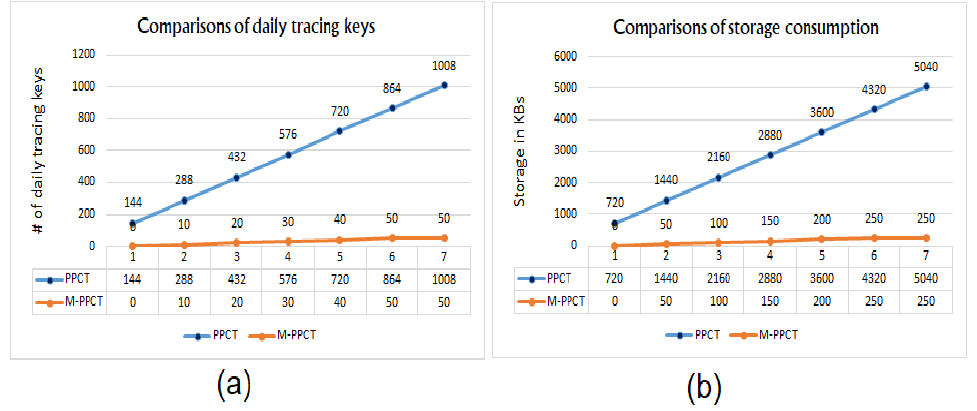
Figure 15. PPCT versus M-PPCT: comparisons of number of keys ( a ) and storage consumption ( b